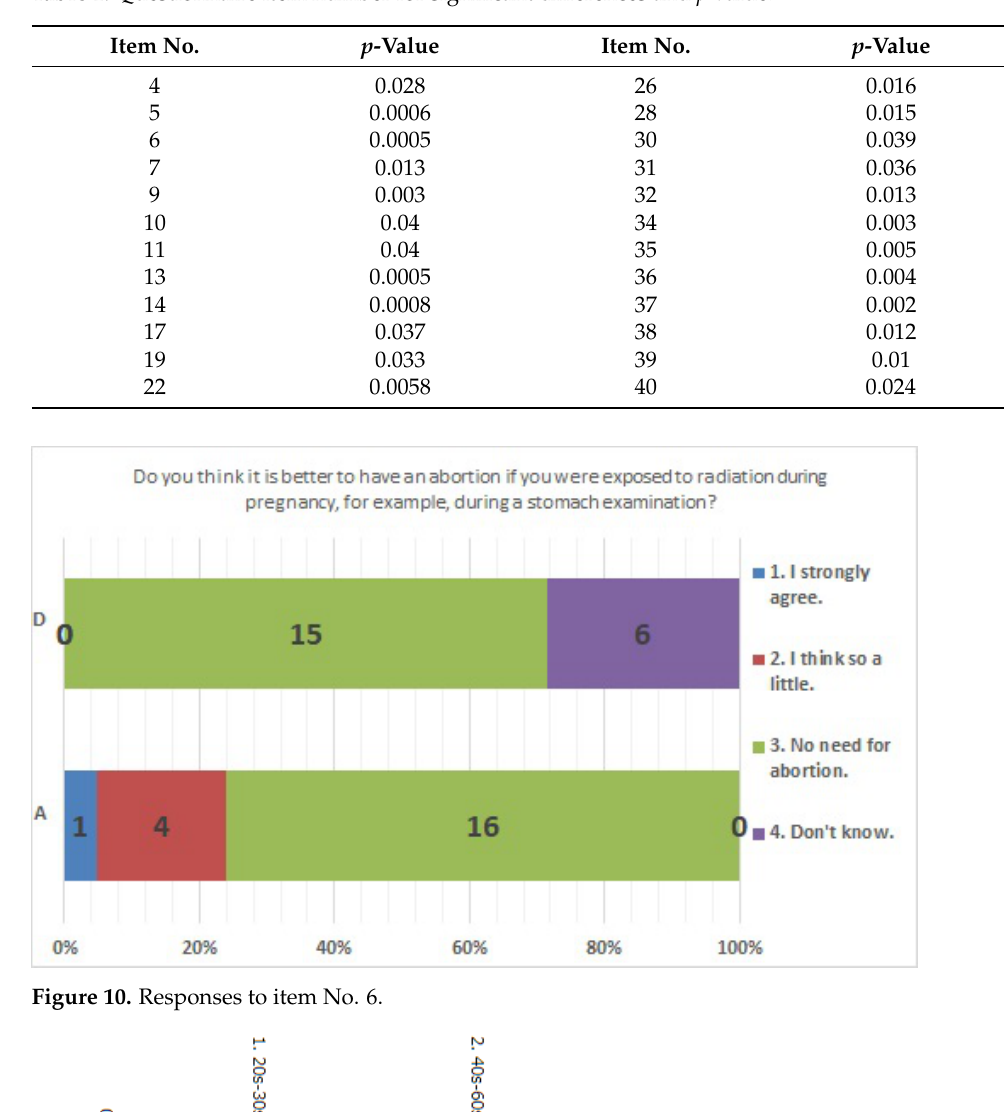
Table 1. Questionnaire item number for significant differences and p value.